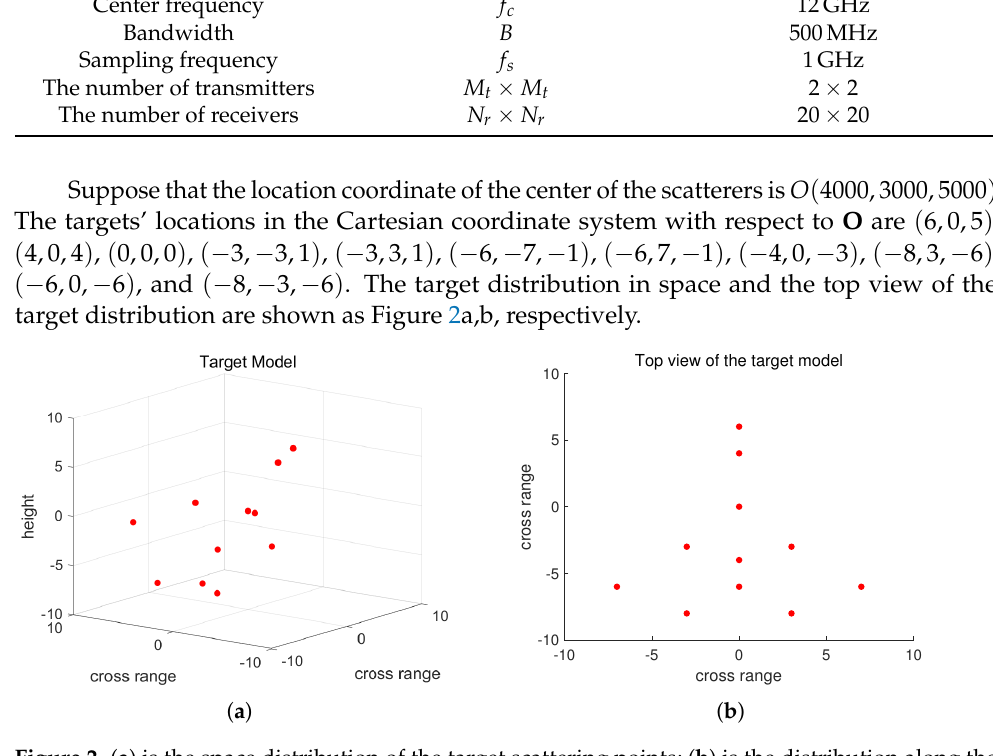
Figure 2. ( a ) is the space distribution of the target scattering points; ( b ) is the distribution along the